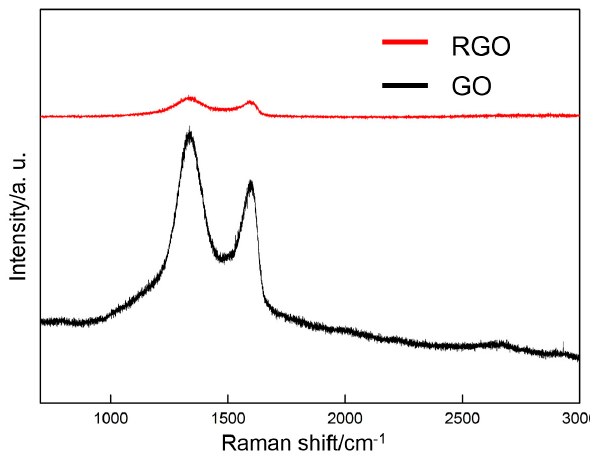
Figure 6. Raman spectra of GO and RGO after thermal reduction (300 °C).